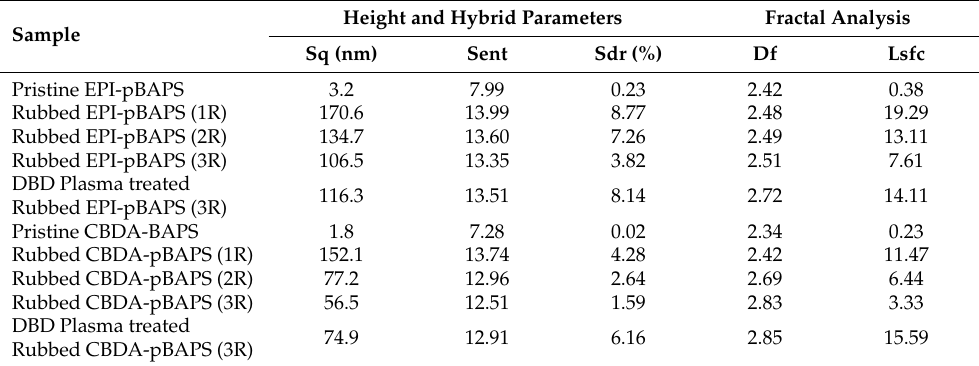
Table 2. Height, hybrid and fractal parameters calculated from the AFM measurements of the pristine, rubbed along different directions and plasma-treated samples, based on the height histogram and furrow